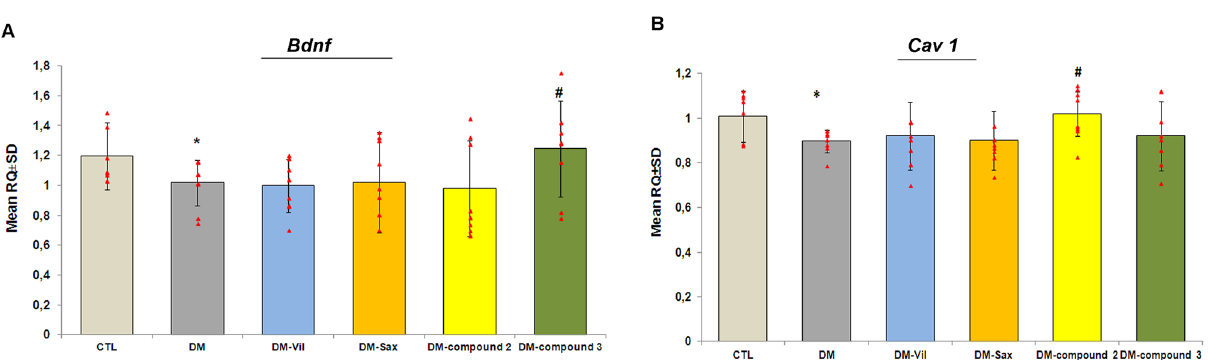
Figure 8. The effects of novel adamantane derivatives (2, 3) and DPP4 inhibitors on Bdnf (A) and Cav1 (B) genes expression in the hippocampus isolated from diabetes mice. Bars in figure illustrate experimental groups— CTL non-diabetic mice, DM diabetic mice, DM‑Vil vildagliptin-treated mice [20 mg/kg, po ], DM‑Sax saxagliptin-treated mice [10 mg/kg, po ], DM‑compound 2 compound 2-treated mice [50 mg/kg, po ], DM compound 3 compound 3-treated mice [50 mg/kg, po ], respectively. Data is presented as mean ± SD (n = 8). One-way ANOVA, followed by Tukey’s post hoc test was used. *p < 0.05 in comparison with control group; # p < 0.05 in comparison with diabetes Bdnf and Cav1 expression levels in the brain of diabetes mice compared to control group (95% CI [0.8708, 1.133], * p < 0.05, F = 1.484; 95% CI [0.8545, 0.9418], * p < 0.05, F = 1.538; Fig. 8A,B, respectively). Our data showed that 14-days treatment of diabetes mice with compound 3 (50 mg/kg, po ) significantly increased Bdnf gene expres- sion in the hippocampus of mice compared to untreated group (95% CI [0.9662, 1.496], * p < 0.05, F = 1.484; Fig. 8A), whereas other compounds did not significantly affect the expression level of the studied gene ( p > 0.05). In turn, a moderate higher expression of Cav1 mRNA level was observed in the hippocampus of animals treated for 14 days with compound 2 when compared to untreated mice (95% CI [0.9260, 1.114], * p < 0.05, F = 1.538;